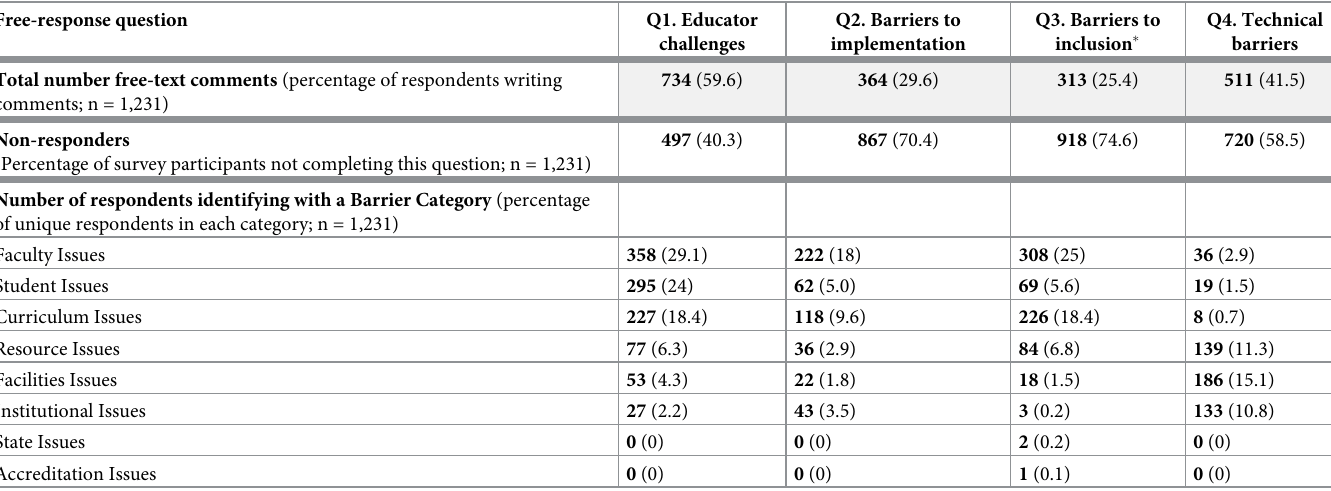
Table 3. Categories by